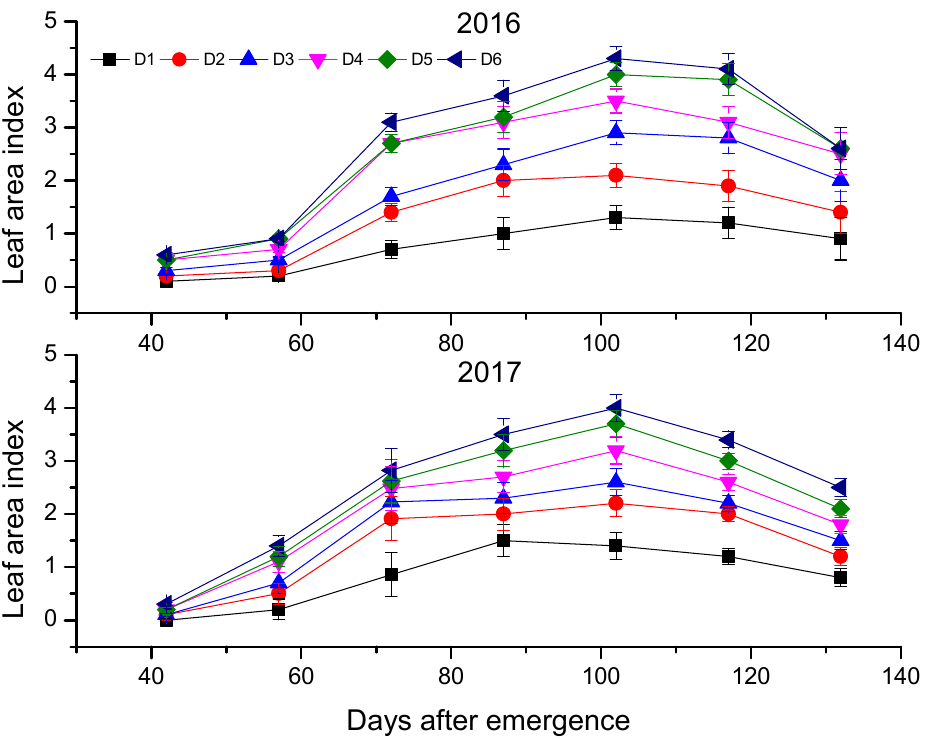
Figure 5. Leaf area index of cotton at different planting densities in 2016 and 2017.